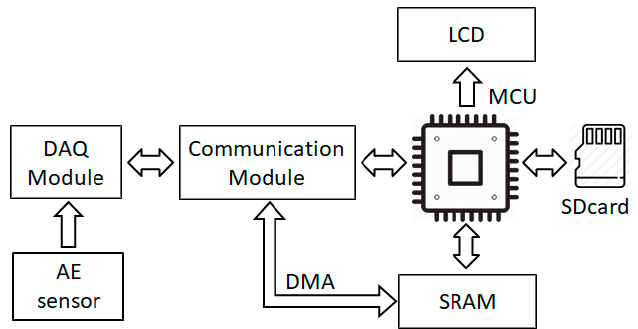
Figure 6. Experimental MCU-based hardware architecture for the gas pipeline leak detection.